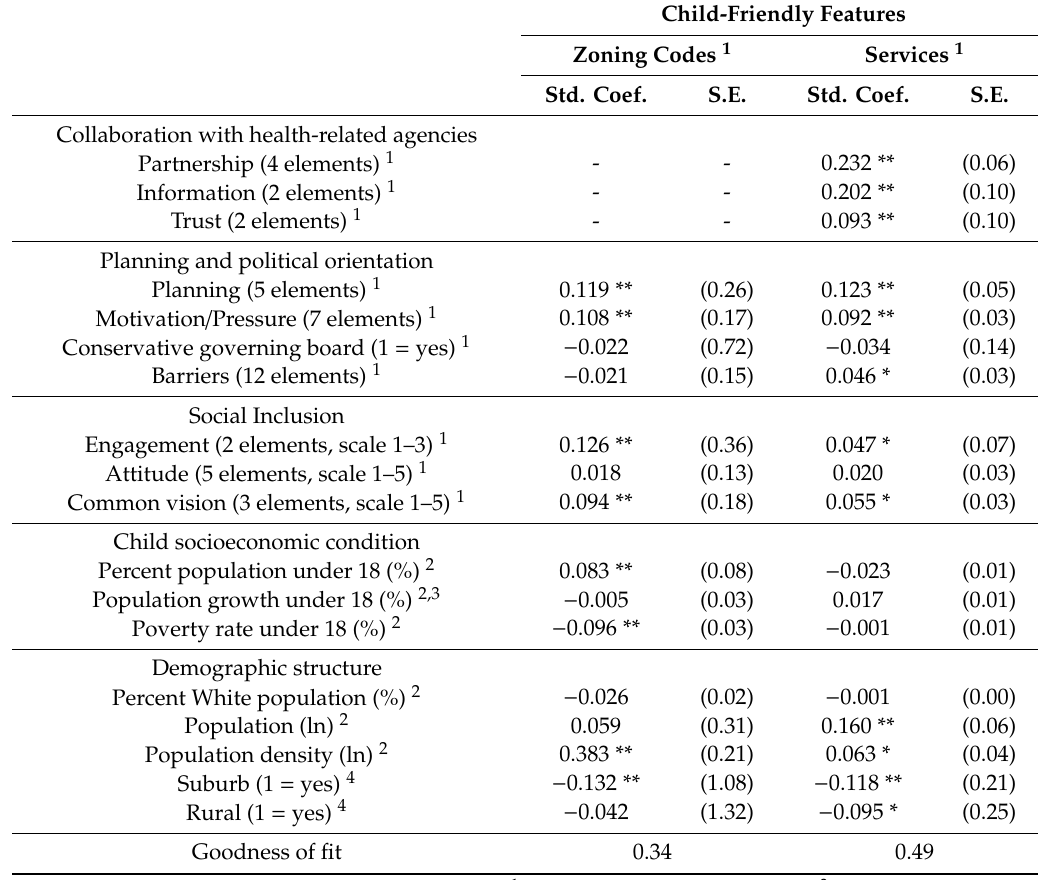
Table 4. Factors related to child-friendly zoning codes and services: SEM model